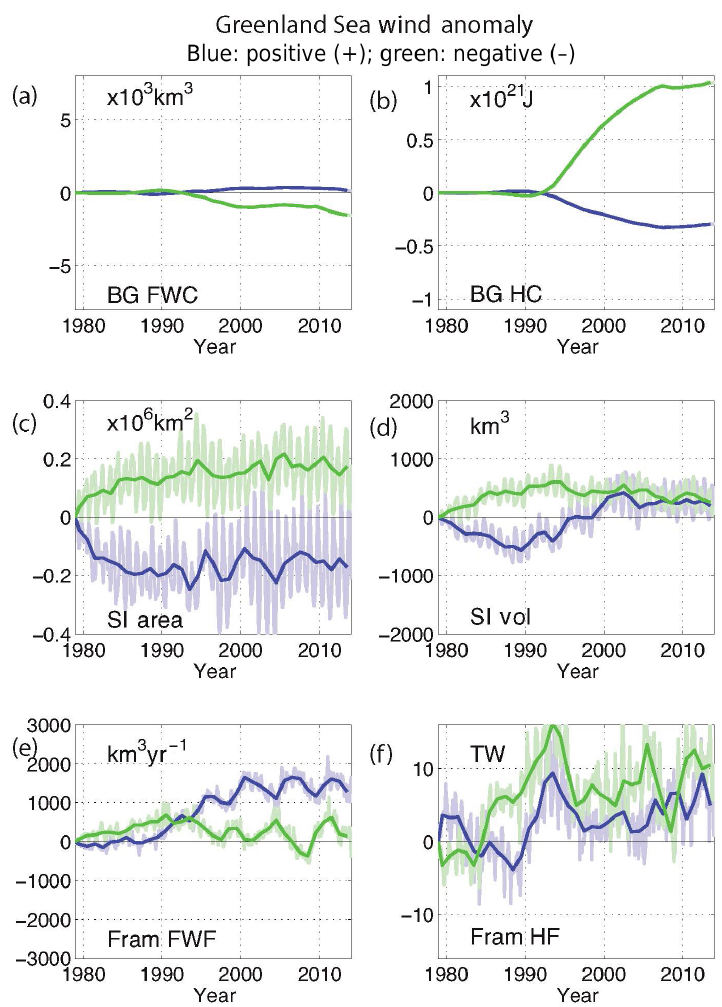
Figure 7. CRFs for the Greenland Sea wind anomaly, blue ( + ) and green ( − ) . Note that the + sign implies a stronger cyclonic forcing. The response to a 4hPa surface pressure anomaly (see Fig. 5b) is shown of (a) C W GS SI area (d) C W GS , SI volume (e) C W GS , FWF through the Fram Strait and (f) C W GS FWF Fram SIV of the y axis appear in the top-left-hand corner of each